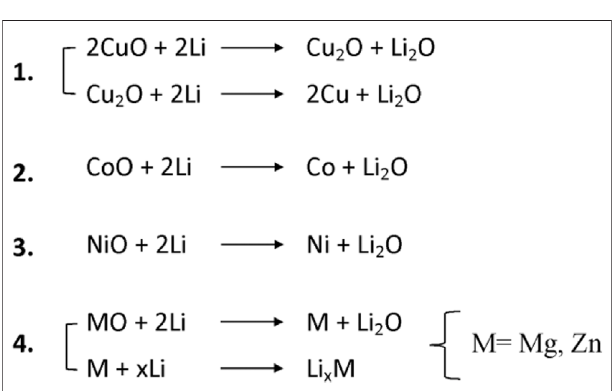
Frontiers in Energy Research |